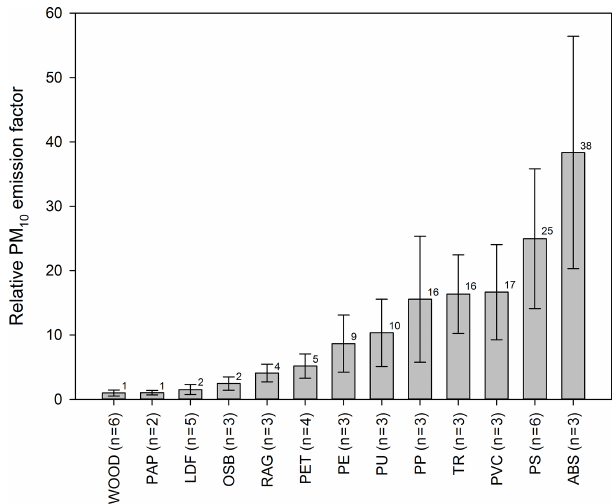
Figure 3. PM 10 emission factors for burning of different waste types relative to the burning of dry fuel wood with a fixed exper- imental